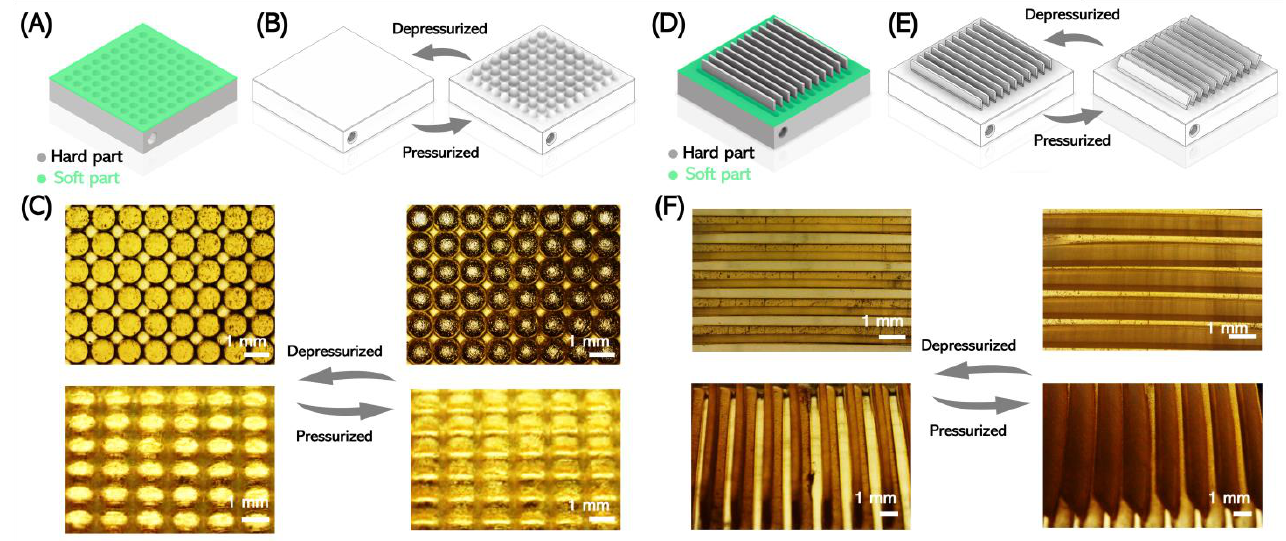
Figure 4. Three-dimensional printing of microactuators. ( A ) Design of a microactuator chip with a threaded pressurized air inlet on the side. The lateral size of the chip was 20 mm × 20 mm × 3 mm, with a soft membrane that was 200 µm in thickness. ( B ) The unactuated state had an even surface; after actuation, the membrane expanded and the inflated sections became visible. ( C ) The printed structure (left) and the actuated state after pressurizing (right). ( D ) Design of a microactuator fin-chip. The lateral size of the chip was 20 mm × 20 mm × 3 mm, with the fins being 14 mm in length, 0.3 mm in thickness, and 2 mm in height. ( E ) The fins were initially in standing mode when the system was not pressurized and tipped over after pressurization. (F ) The printed pneumatic-driven fins (left) and the actuated state